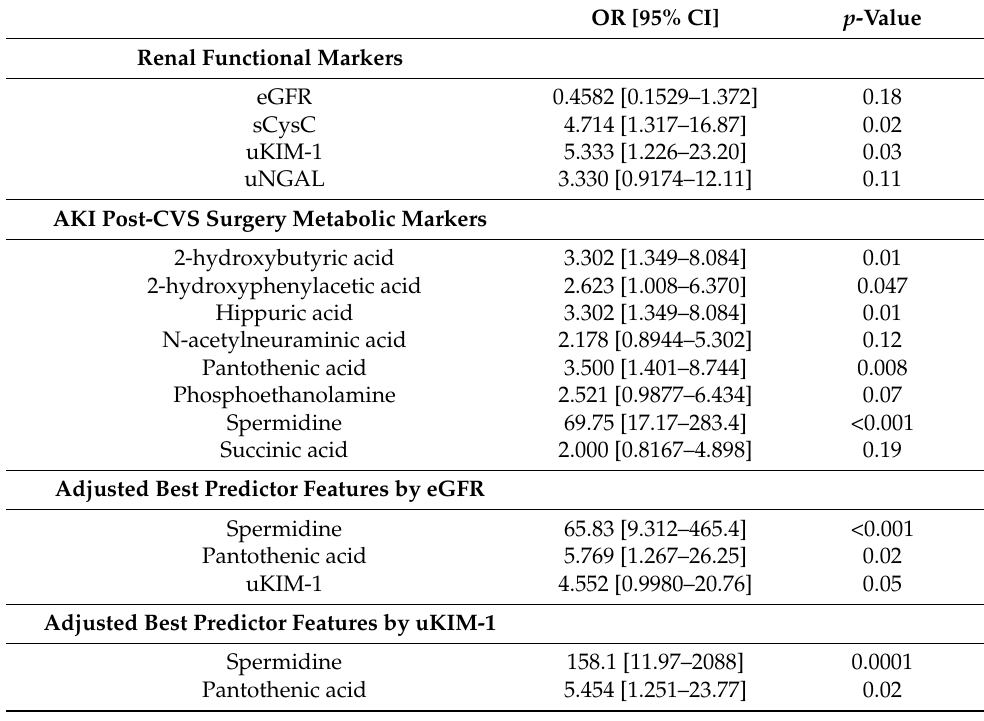
Table 3. Logistic regression evaluation for the association of independent features with in-hospital AKI